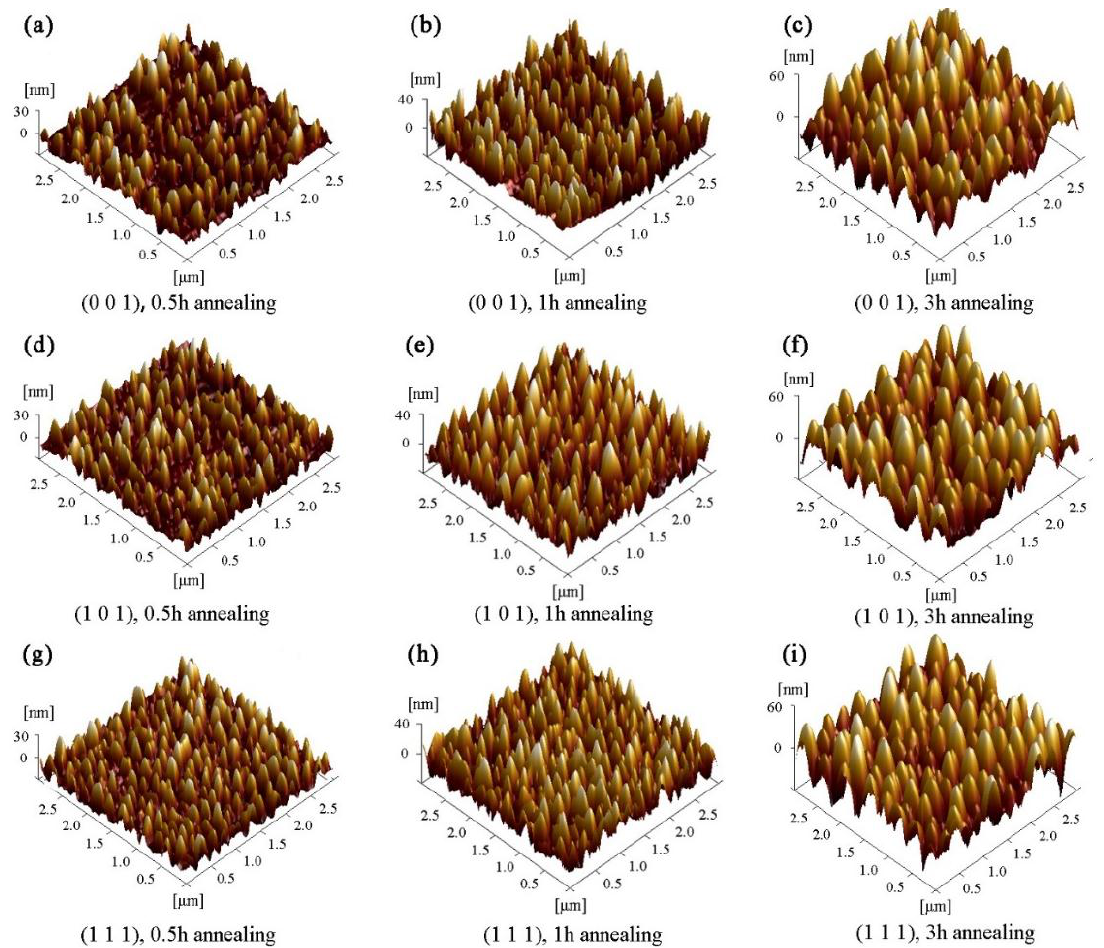
Figure 3. Atomic force microscopy (AFM) 3D images of the irradiated tungsten surface with (0 0 1) orientation after ( a ) 0.5 h, ( b ) 1 h and ( c ) 3 h of annealing; with (1 0 1) orientation after ( d ) 0.5 h, ( e ) 1 h and ( f ) 3 h of annealing; with (1 1 1) orientation after ( g ) 0.5 h, ( h ) 1 h and ( i ) 3 h of annealing.